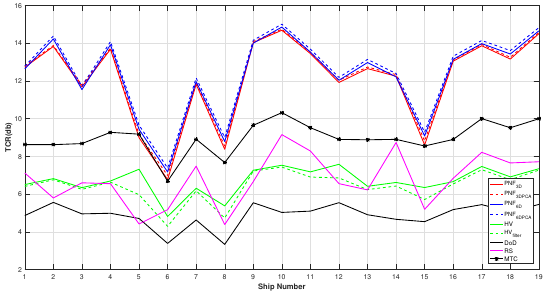
Figure 8. TCR values of the 19 ships in